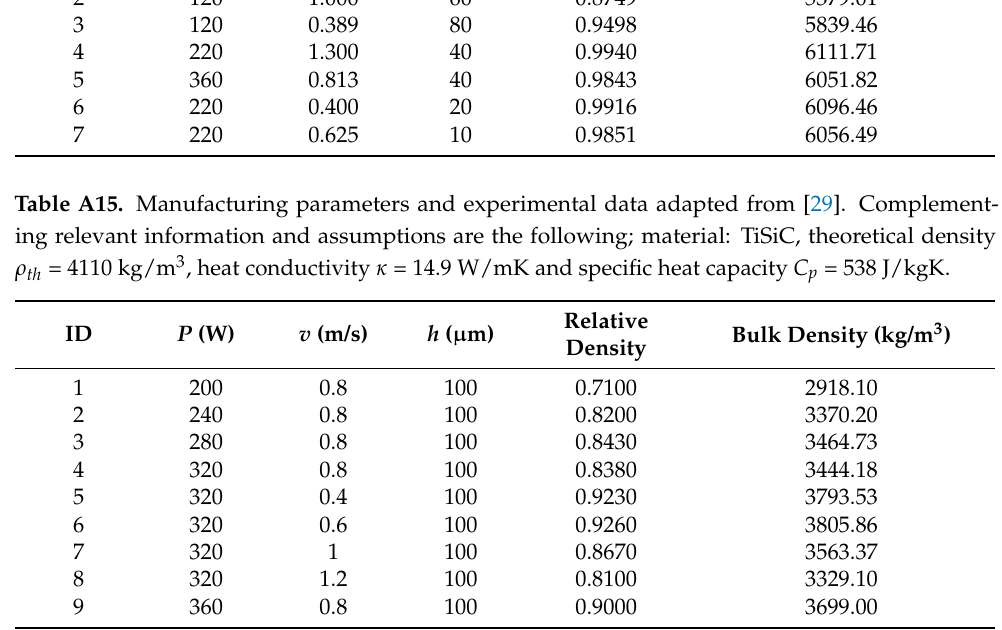
Table A16. Manufacturing parameters and experimental data, adapted from [30]. Complement- ing relevant information and assumptions are the following; material: W, theoretical